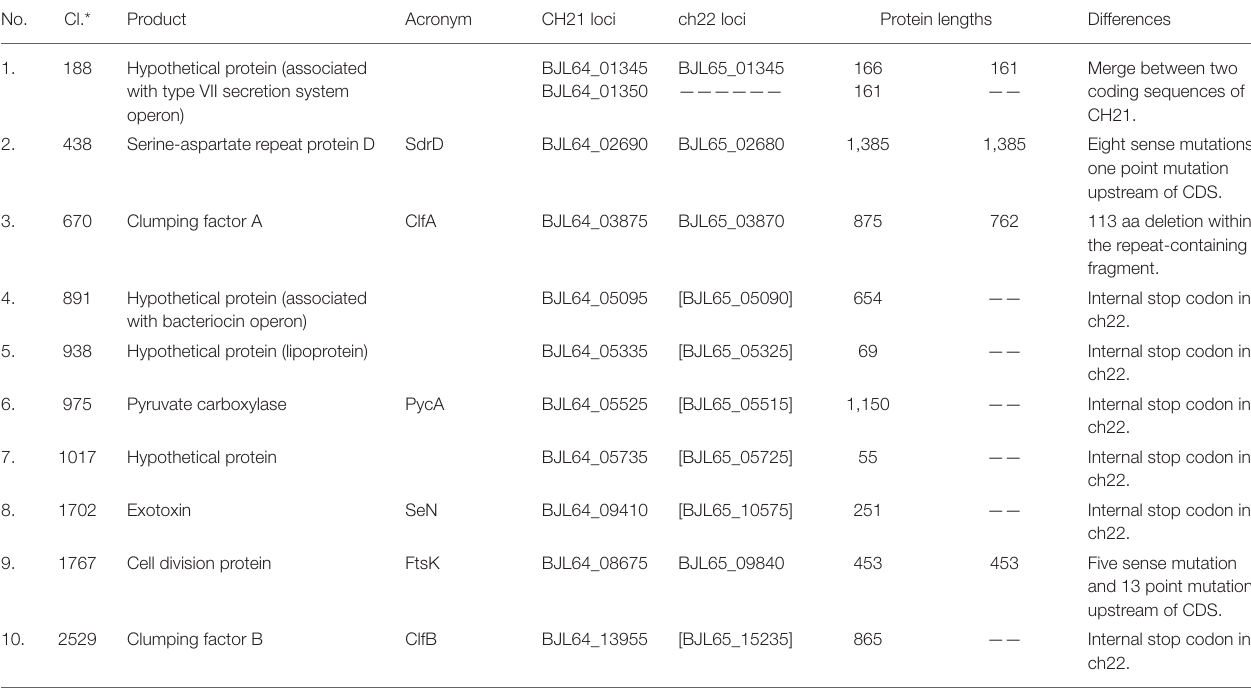
* Cluster’s number, for detailed protein sequences and alignment see “https://mol058.mol.uj.edu.pl/extra/clusters.htm.”